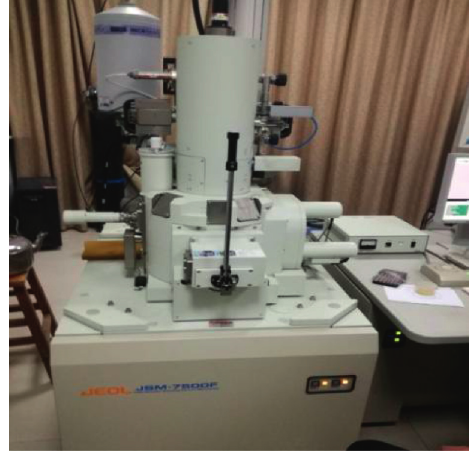
Figure 12: Scanning electron microscope.